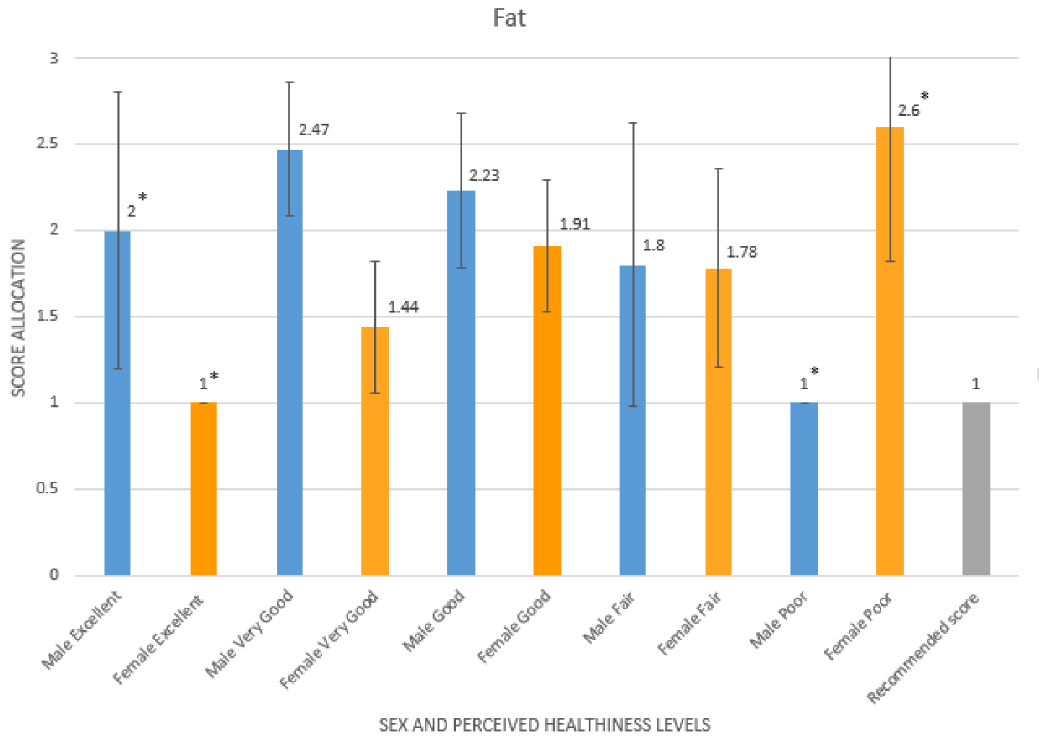
Figure 5. Mean fat food group score allocation from the Short Form FFQ evaluated using DANTE tool per sex and perceived healthiness levels compared to the recommended fat food group score (* indicates significant differences).